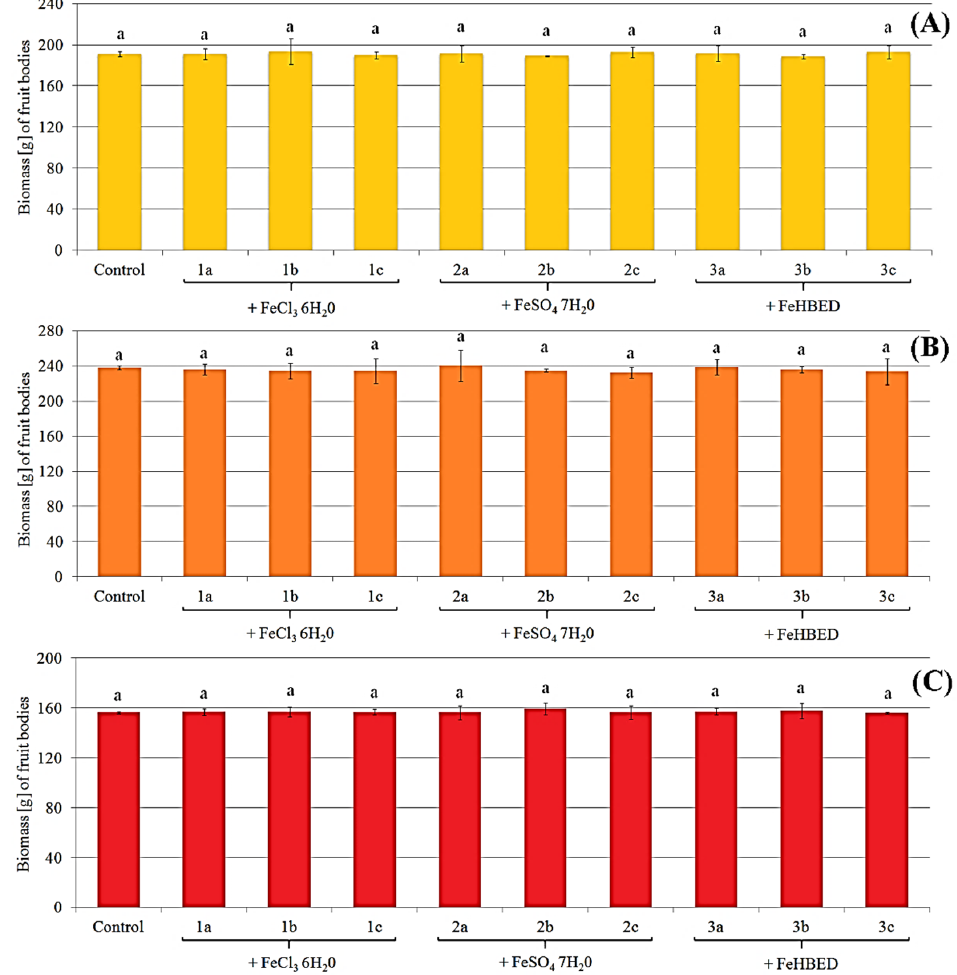
Figure 2. Yield (g) of P. eryngii ( A ), P. ostreatus ( B ), and P. nameko ( C ) exposed to particular experimental systems. n = 3, identical lower cases ( a , b …) denote non-significant differences between mean mushroom yield growing in particular experimental systems according to post-hoc Tukey’s HSD